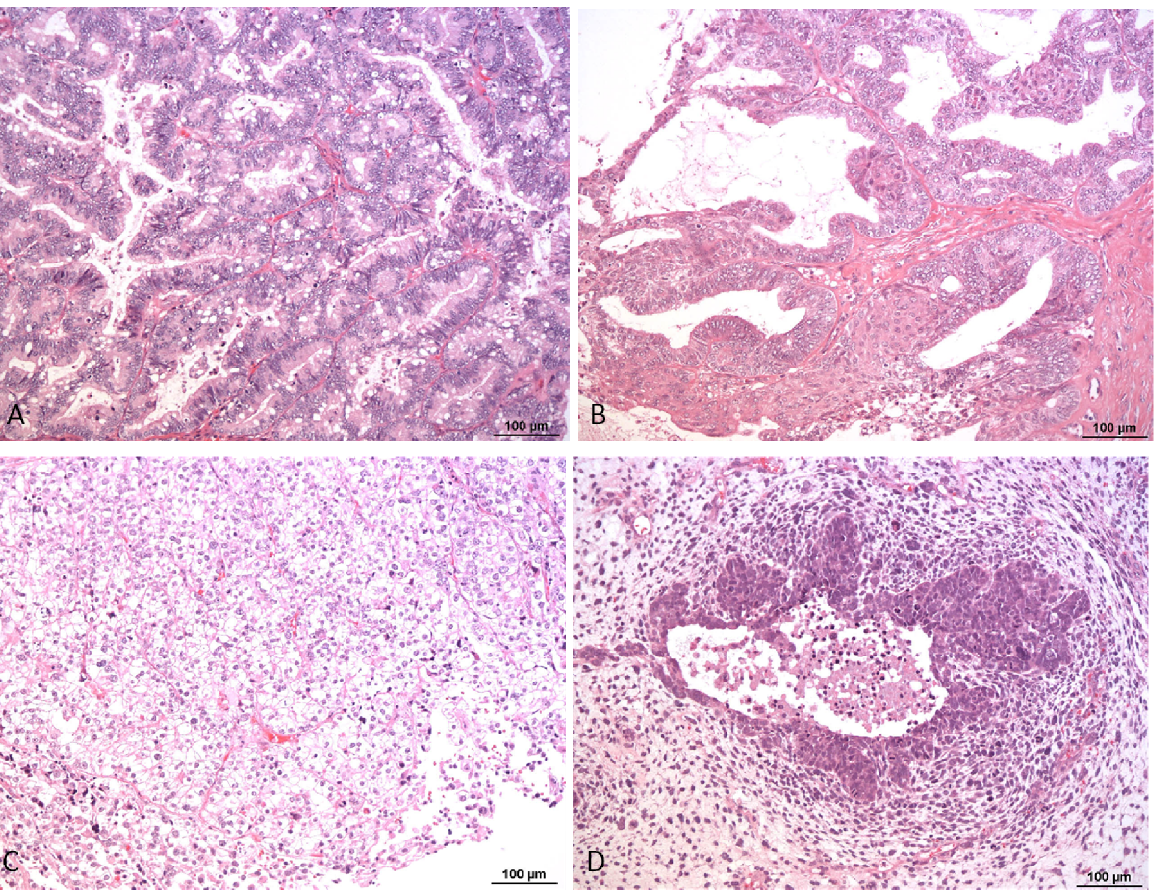
Figure 2. Mucinous ( A ), endometrioid ( B ), clear cell carcinoma ( C ) and mixed malignant mesodermal tumor (MMMT) ( D ). HE, 100×.